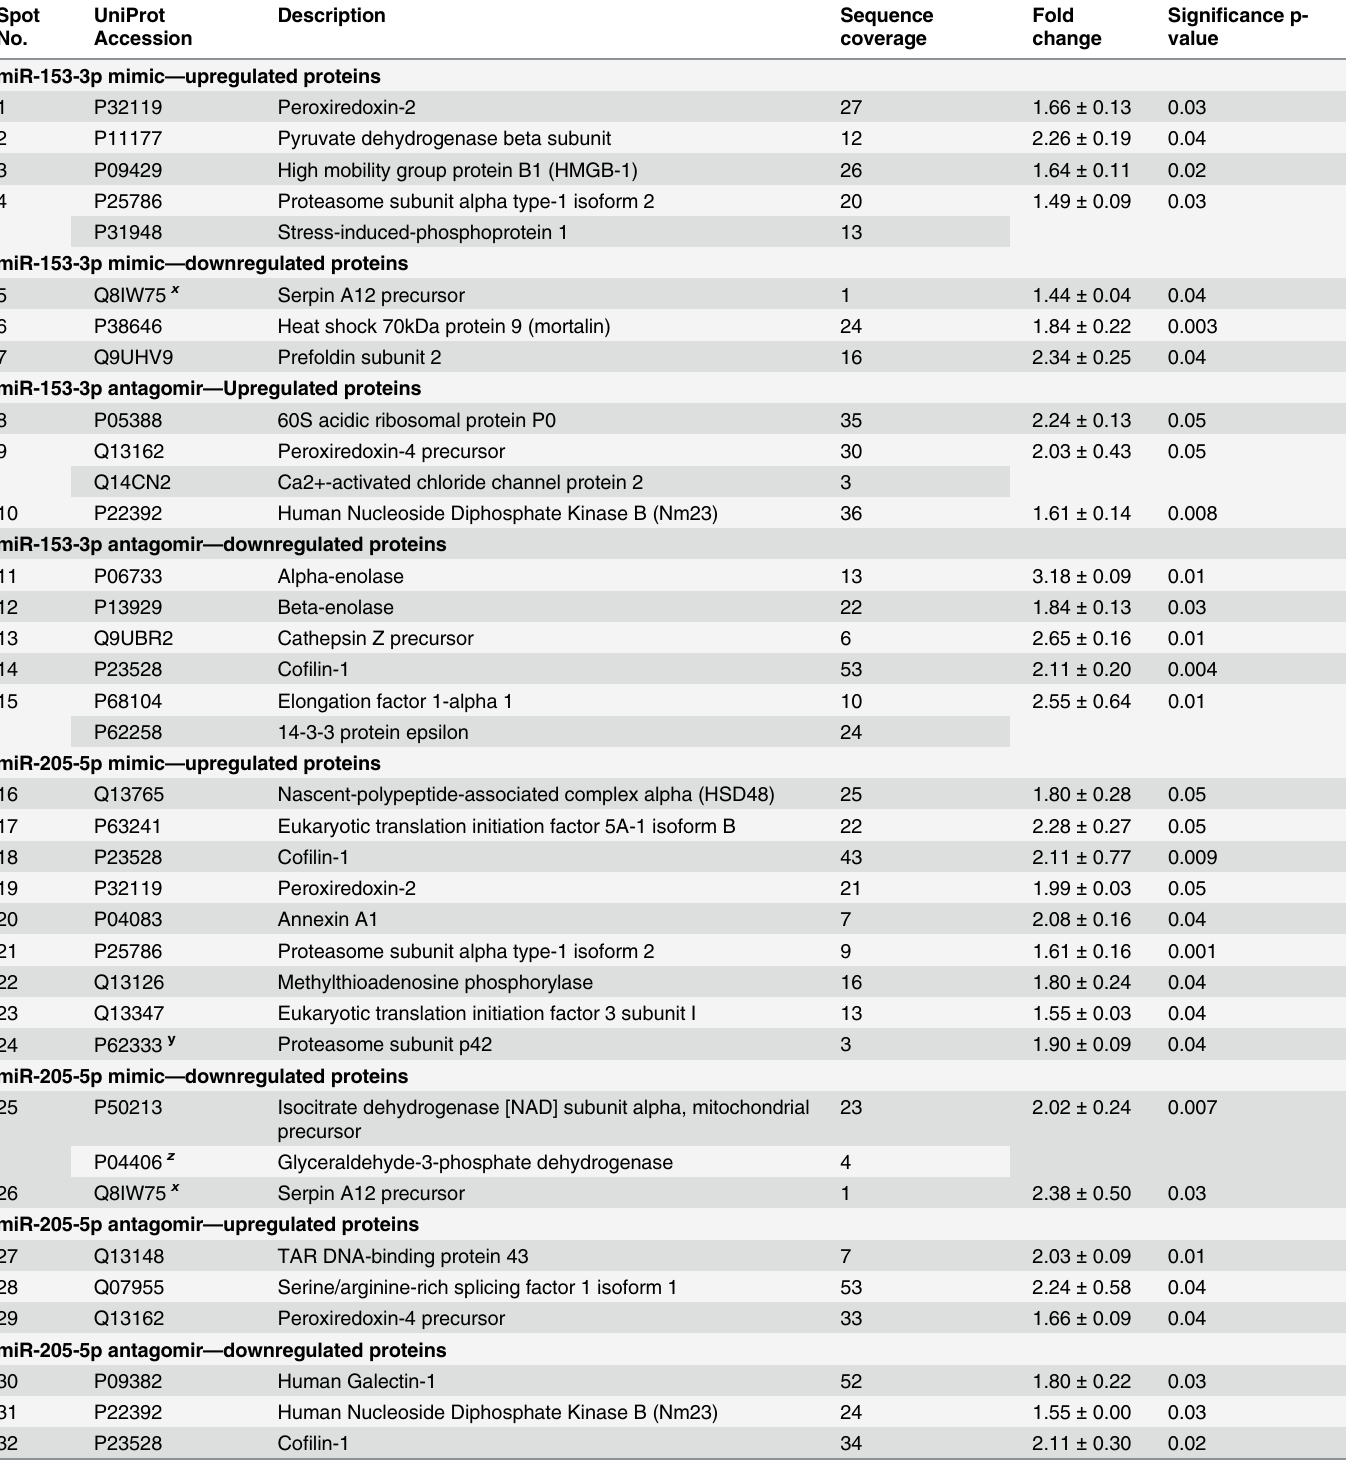
Table 1. List of differentially regulated proteins in SH-SY5Y cells in response to mimics and antagomirs of miR-153-3p and miR-205-5p. Spot